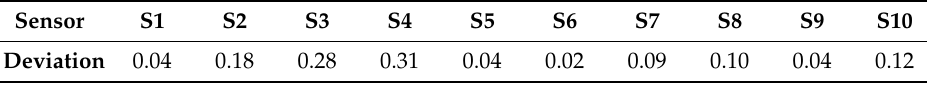
Table 3. Deviations of each sensor measurement in relation to the mean value.